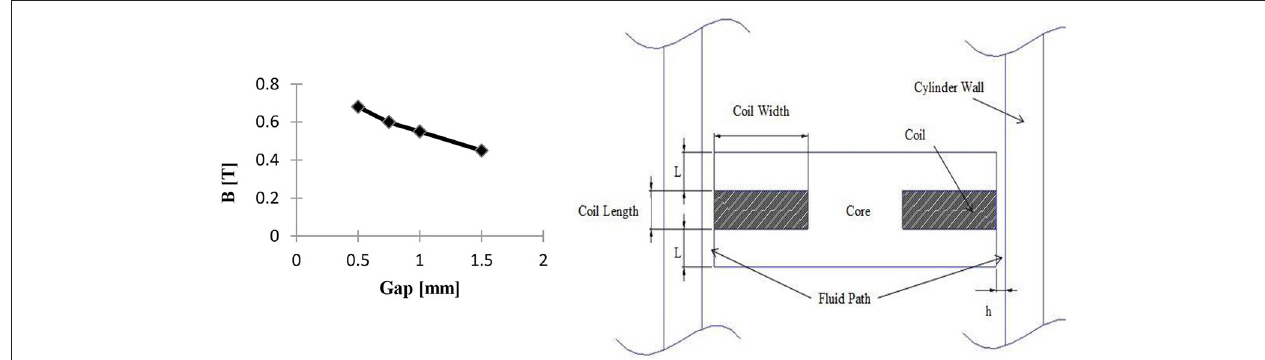
FIGURE 4 | (Left) The magnetic field density at 5 Amps decreases as the gap width increases from 0.5 to 1.5mm. In order not to exceed the load limit of 11.1 kN (2,500 lb) at 4Hz and 5 Amps, it is necessary to incorporate a 1mm gap. (Right) The diagram of electromagnetic piston and annular valve. Reproduced with permission from Maus and Gordaninejad